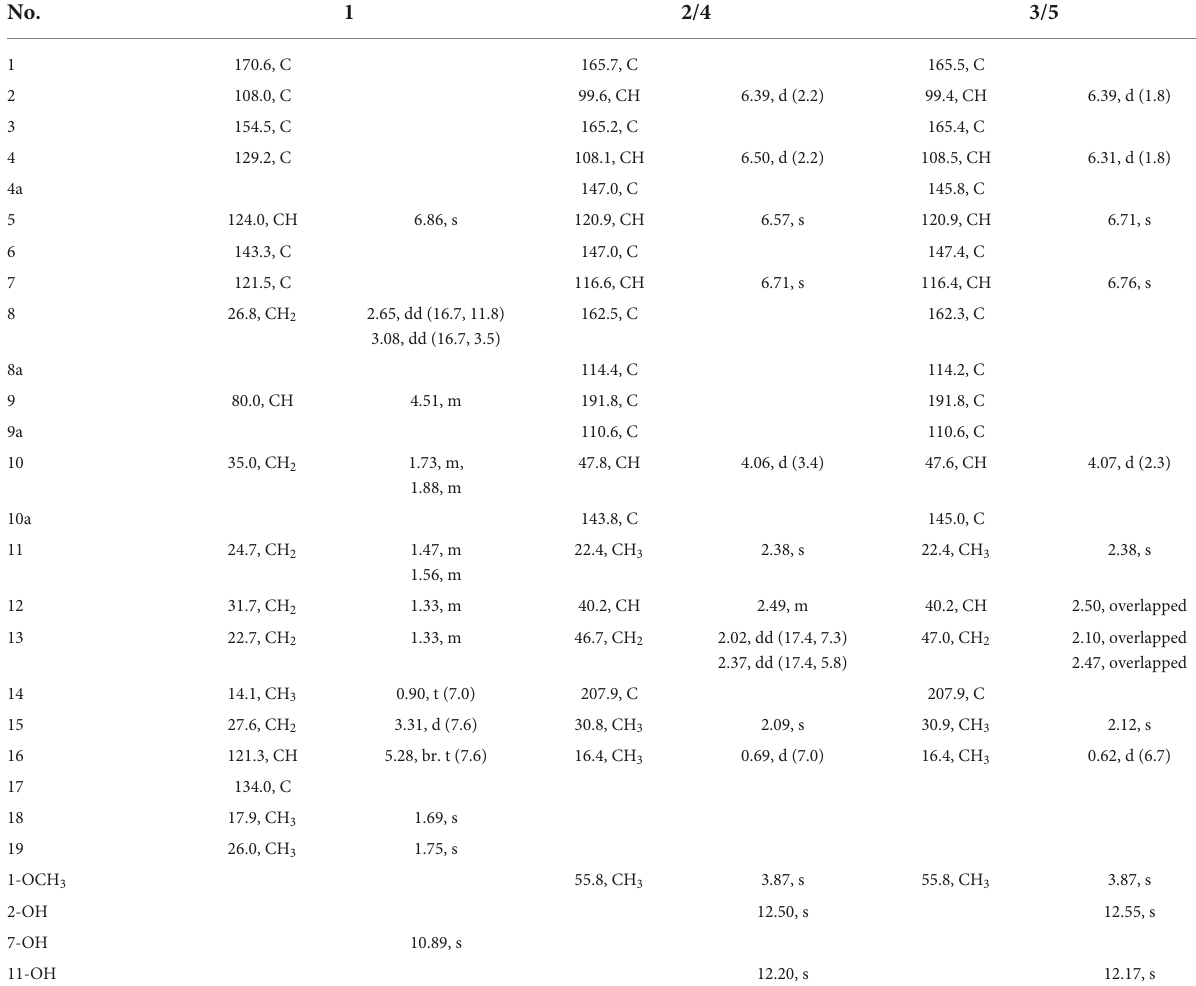
TABLE 1 1 H and 13 C nuclear magnetic resonance (NMR) spectroscopic data of compounds 1–5 (600/150 MHz, CDCl 3 ).